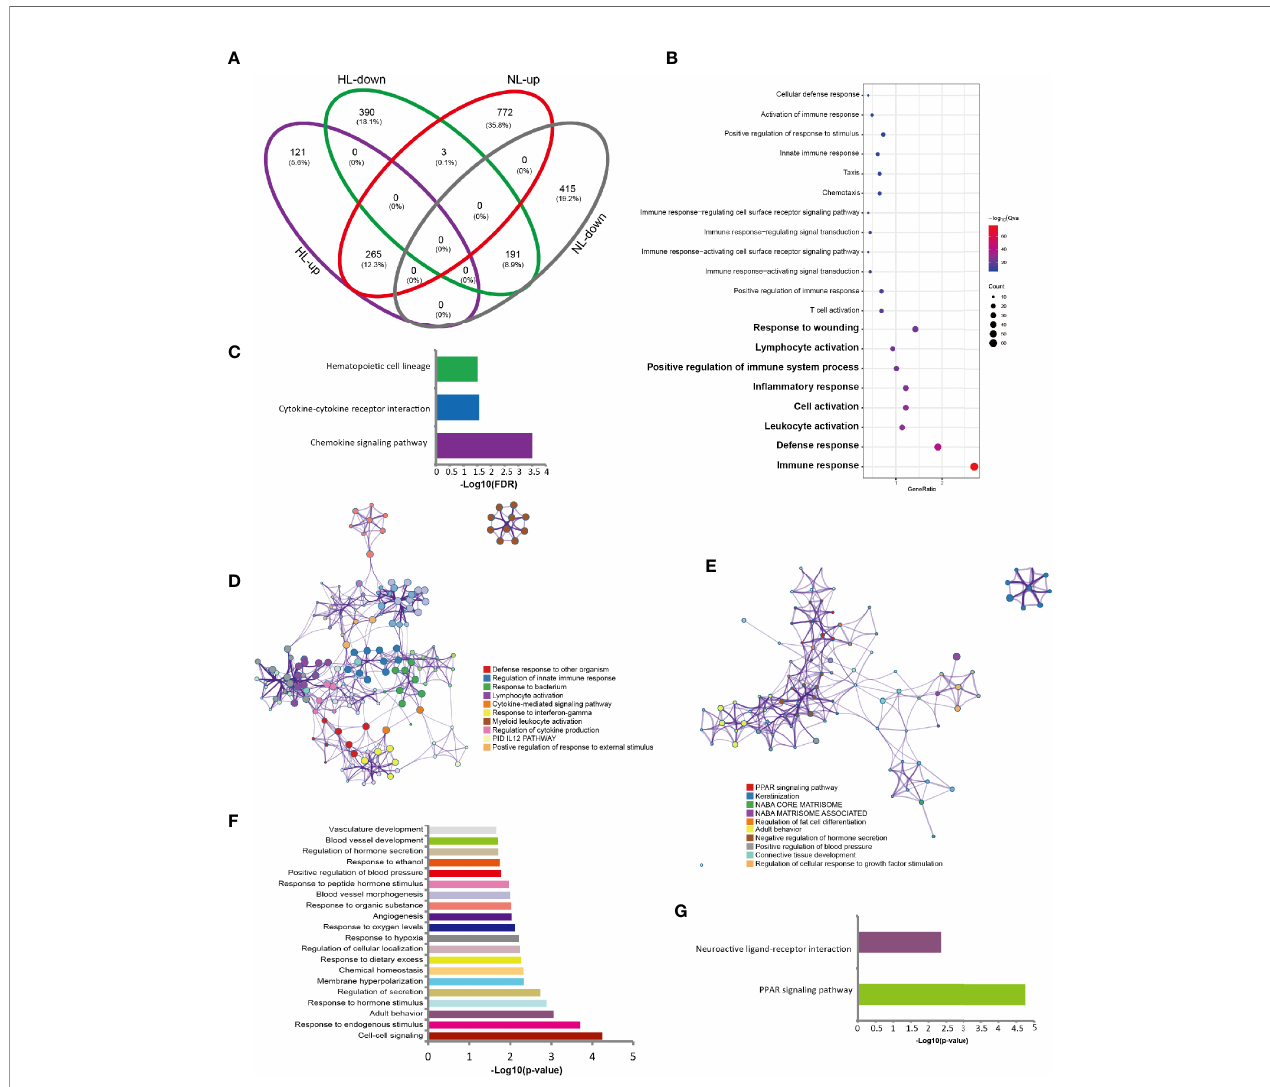
FIGURE 3 | Gene signatures in rosacea lesions compared with central facial skin and skin surrounding the auricle. (A) Venn plot of the DEGs shared between rosacea lesions and matched normal skin surrounding the auricle (LS vs NS) and central facial skin from healthy controls (LS vs HS). HL: LS vs HS; NL: LS vs NS; up: upregulated genes; down: downregulated genes. LS, lesion skin; HS, healthy skin; NS, matched normal skin. (B) Go terms for the 265 shared upregulated genes showing the immune-related biological processes. (C) Results of KEGG pathway enrichment analysis of 265 shared upregulated genes. (D) Metascape network analysis of the GO terms enriched for the 265 shared upregulated genes involved in immune responses, including defense response to other organism, and regulation of innate immune response. (E) Metascape network analysis of the enrichment of the 191 shared downregulated genes for biological processes, such as the PPAR signaling pathway, and keratinization. (F) GO terms for the 191 shared downregulated genes by DAVID analysis. (G) Enriched pathways for the 191 shared downregulated genes, showing PPAR signaling